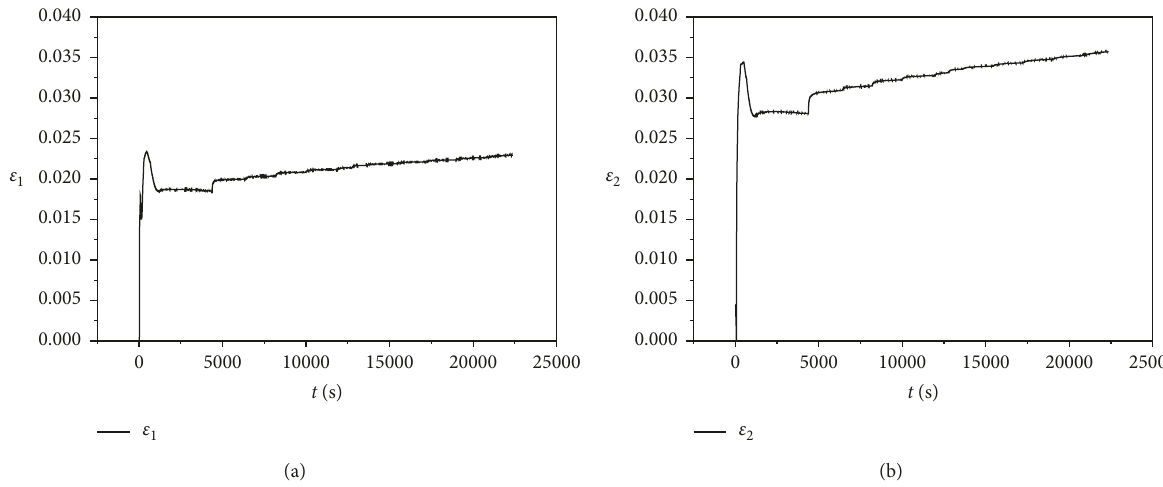
Figure 4: (a) Radial strain-time and (b) axial strain-time curves during gas depressurization